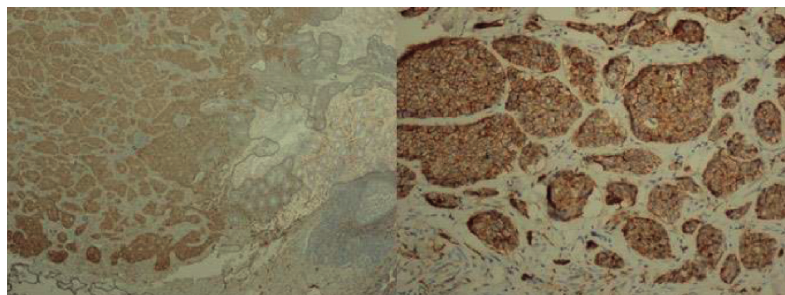
Figure 6: In immunohistochemical examination, CD56 is positive in tumoral tissue.